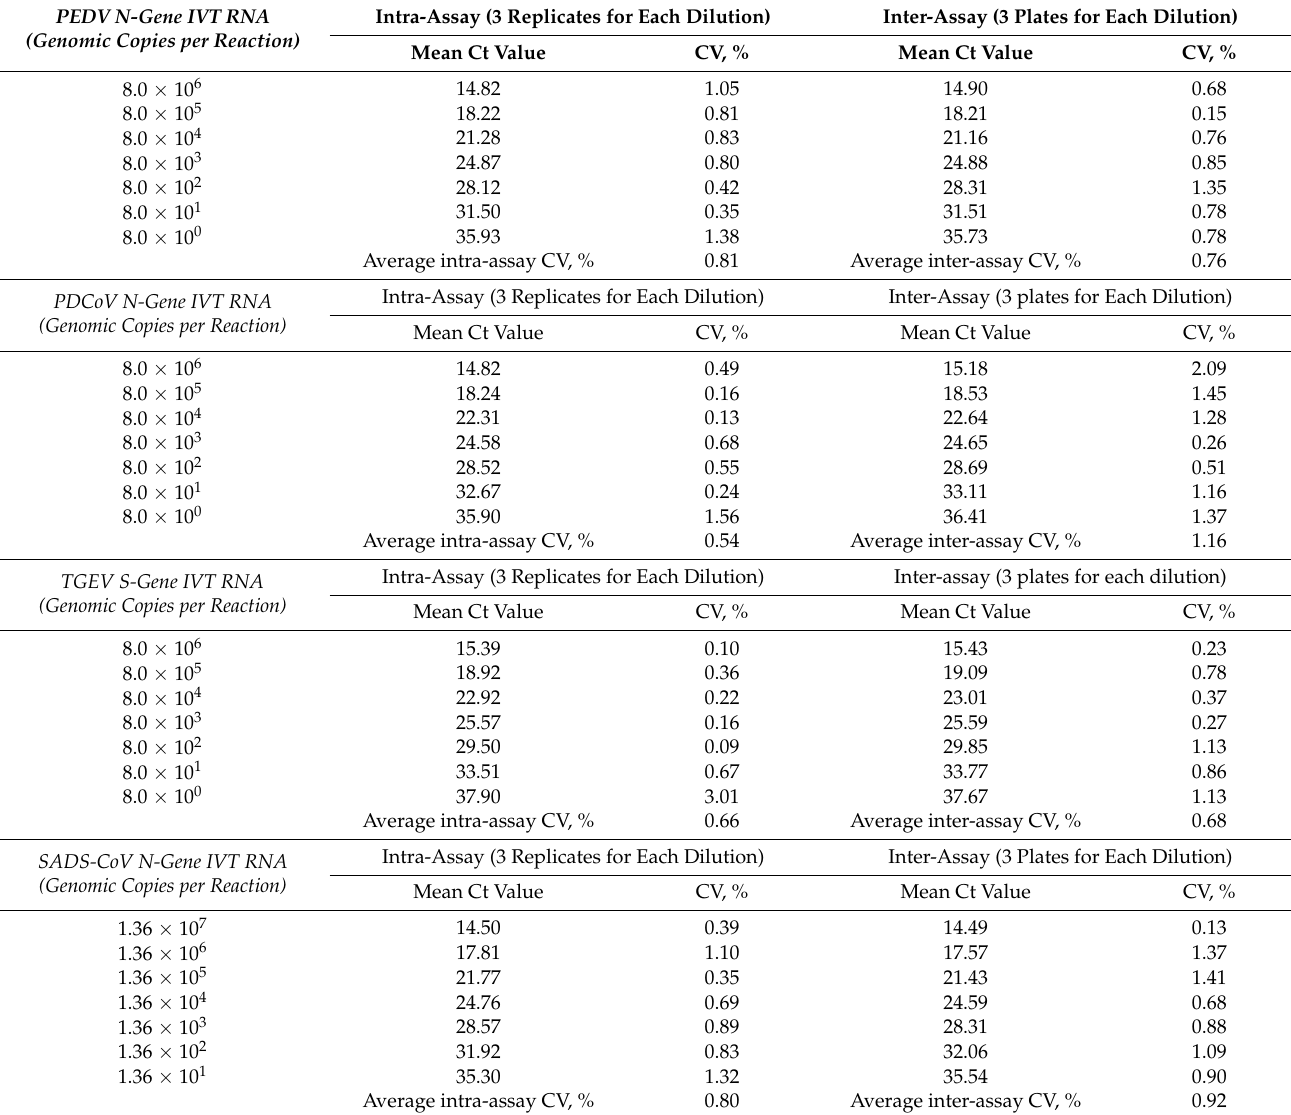
Table 7. Repeatability of PEDV/PDCoV/TGEV/SADS-CoV/XIPC 5-plex PCR by testing serial dilutions of in vitro transcribed